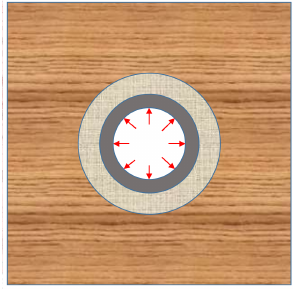
Figure 1. Sketch of the traditional